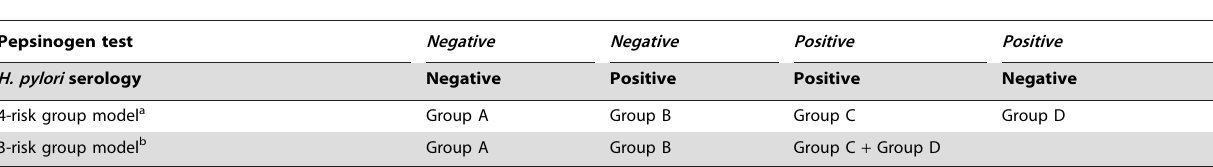
Table 1. Gastric cancer risk groups defined by the pepsinogen test and H. pylori antibody.